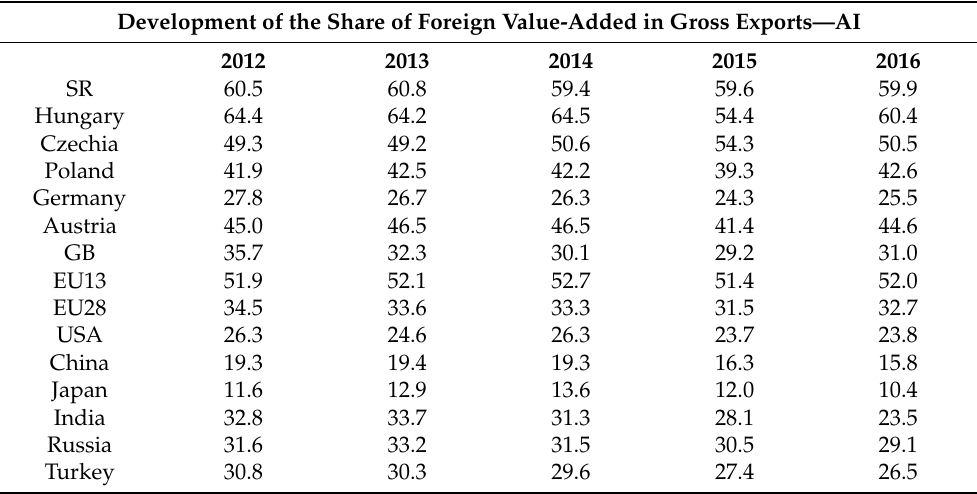
Table 5. Development of the share of foreign value-added in gross exports—automotive.